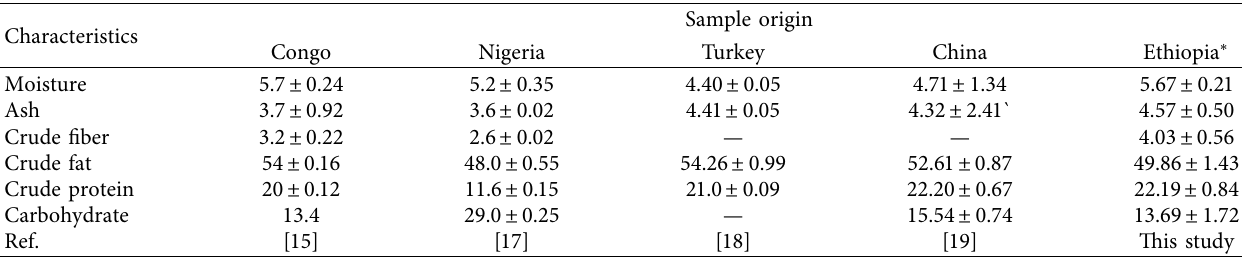
Table 3: Comparison of the proximate composition (%w/w dry weight) of white sesame seeds from diferent countries.